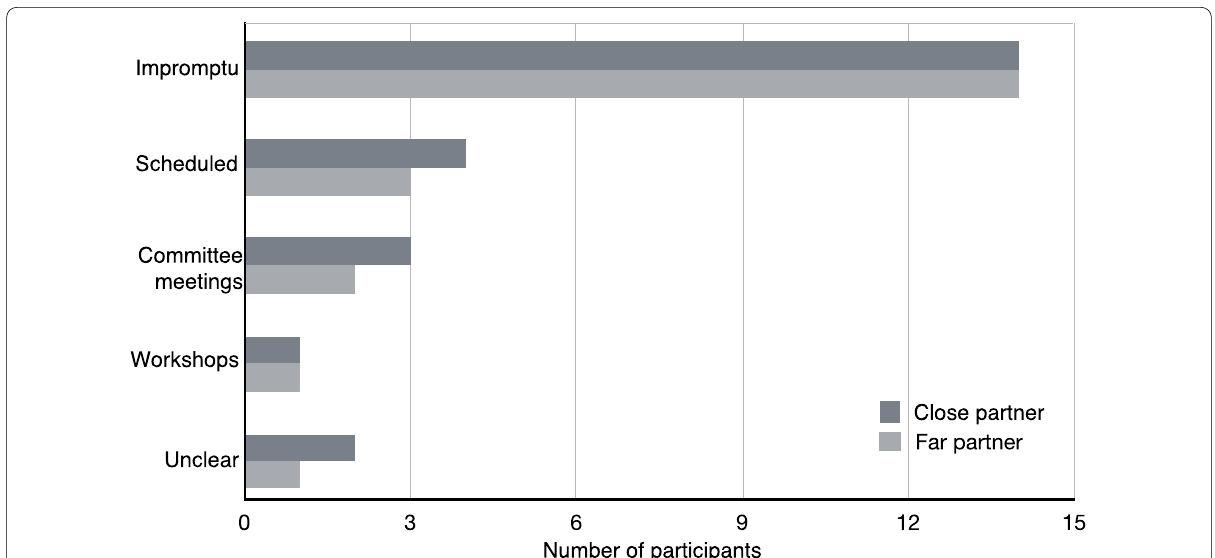
Fig. 3 Nature of the conversations between faculty and their discussion partners. Bars represent the number of interview participants ( n whose interactions with close (dark gray) and far (light gray) partners occurred predominantly in each different context. Discussion pairs could have more than one